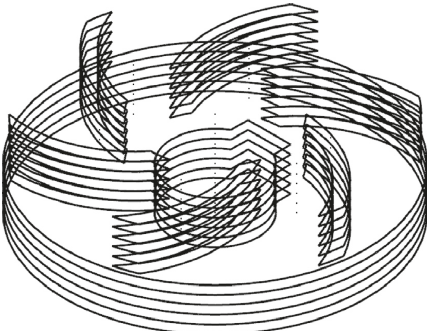
Figure 16: Slices of the impeller with reusable substrate method.